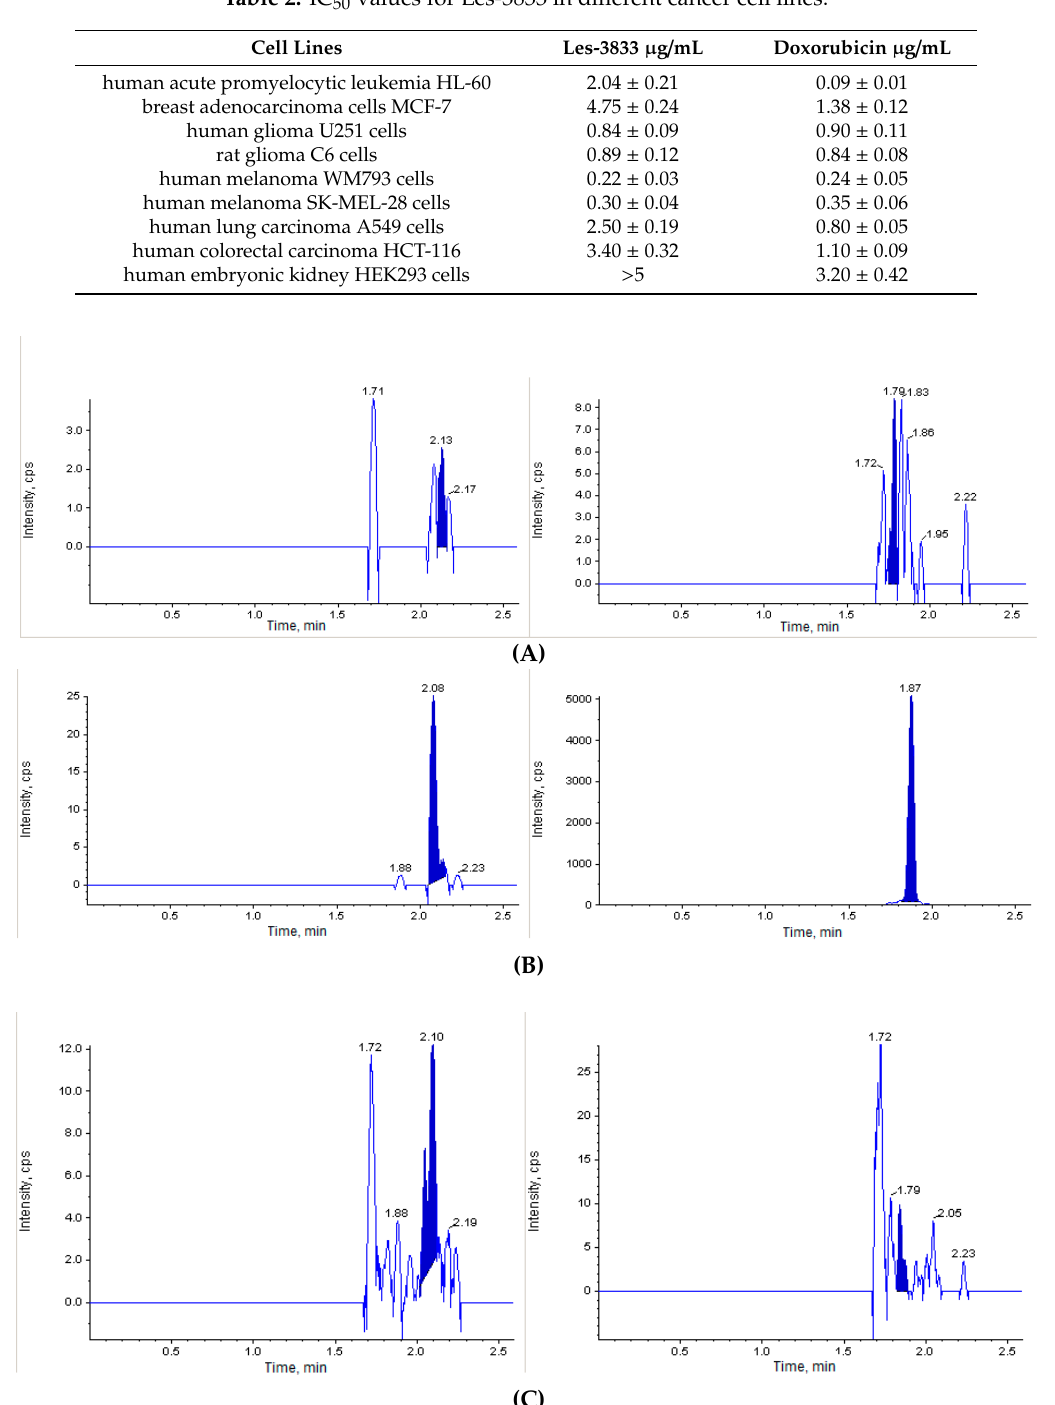
Table 2. IC 50 values for Les-3833 in di ff erent cancer cell